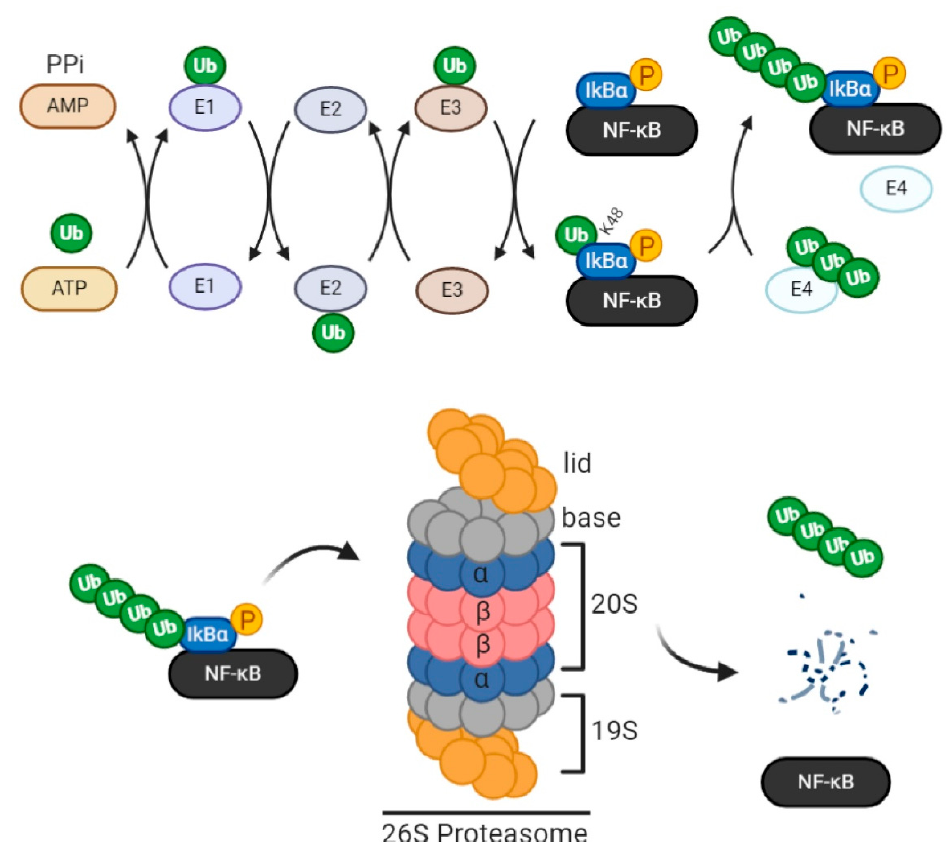
Figure 1. Components of the ubiquitin proteasome system (UPS). Protein ubiquitination is catalyzed sequentially by the ubiquitin-activating enzyme (E1), ubiquitin conjugation (E2) enzyme, and ubiquitin ligase (E3). First, the E1 enzyme binds and activates ubiquitin by consuming ATP. Then E2 forms an intermediate complex with activated ubiquitin. Lastly, E3 acts as a scaffold that interacts with both the E2-ubiquitin complex and the protein substrate, facilitating the transfer of ubiquitin from E2 to the substrate. An iso-peptide bond, thus, forms between the c-terminal glycine residue of ubiquitin and consensus lysine residues (7 total) of the substrate. Internal ubiquitin linkage at K11, 29, and 48 residues constitutes a tag for proteasomal trafficking. E4 ligase, a specific E3 subtype, can further elongate linear ubiquitin chains to create several polyubiquitin chain conformations. In this example, NF- κ B is the protein substrate. Following its phosphorylation by IKK, I κ B (inhibitory subunit of NF- κ B) is polyubiquitinated for proteasomal trafficking. The standard proteasome 26S groups two regulatory subunits (19S each) comprising 2 multimers each, the lid and the base, in addition to a catalytic core (20S) whose β rings harbor caspase-, trypsin-, and chymotrypsin-like proteolytic activities ( β 1, β 2, and β 5, respectively). Upon substrate entry into the proteasome lid, the base facilitates the opening of the entry pore of 20S α rings, enabling protein translocation and degra- dation in the core by β rings. Furthermore, the base, due to the chaperone-like activity of its highly specific ubiquitin receptor subunits, ensures the selectivity of degradation, as it permits the entry of ubiquitinated proteins only, by forming covalent bonds with monomeric or polymeric ubiquitin chains. The 19S subunit also contains deubiquitinating enzymes (DUBs) that facilitate protein unfold- ing, translocation, and degradation within the core. In the given scenario, I κ B is deubiquitinated and degraded within the proteasome so that activated NF- κ B becomes free to